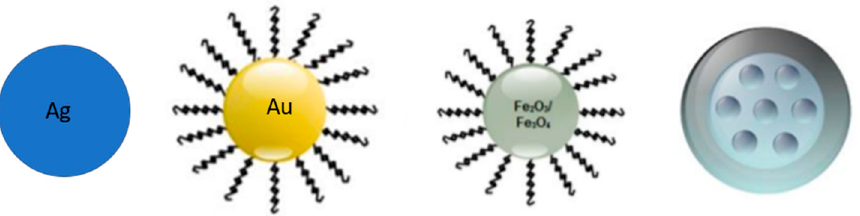
Figure 2. Schematic representation of inorganic nanoparticles (AgNPs, AuNPs, MNPs and PSi NPs) [48].